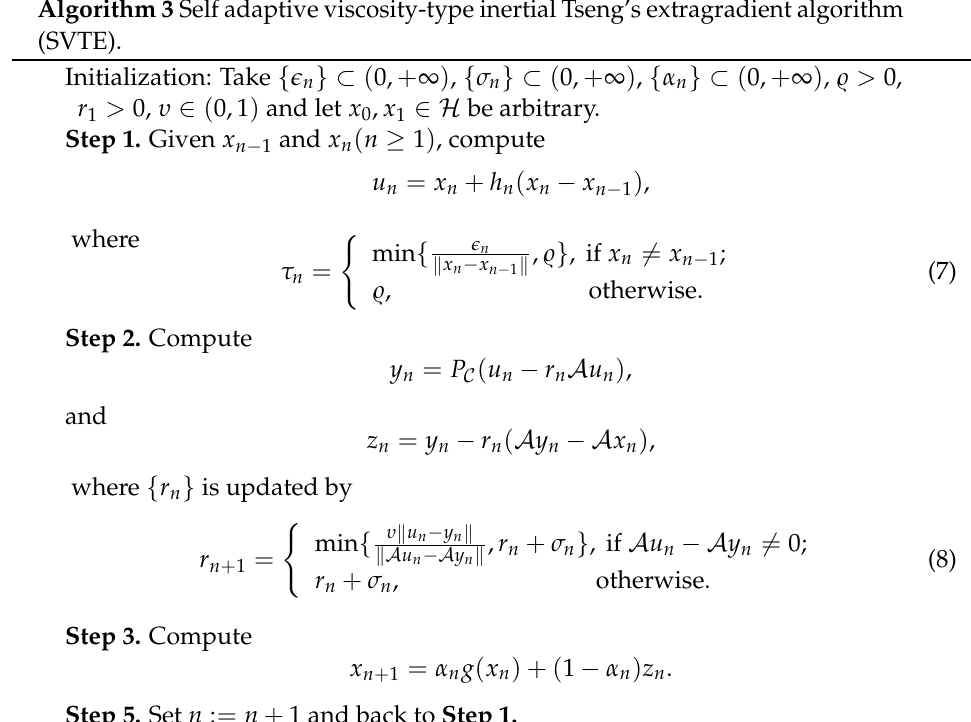
Algorithm 3 Self adaptive viscosity-type inertial Tseng’s extragradient algorithm